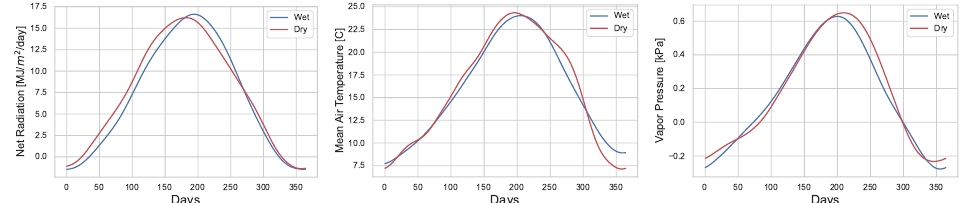
Figure 4. Plots of daily averages for environmental parameters for wet and dry seasons. Net radiation is on the ( left ), temperature is in the ( middle ), and vapor pressure is on the ( right ).